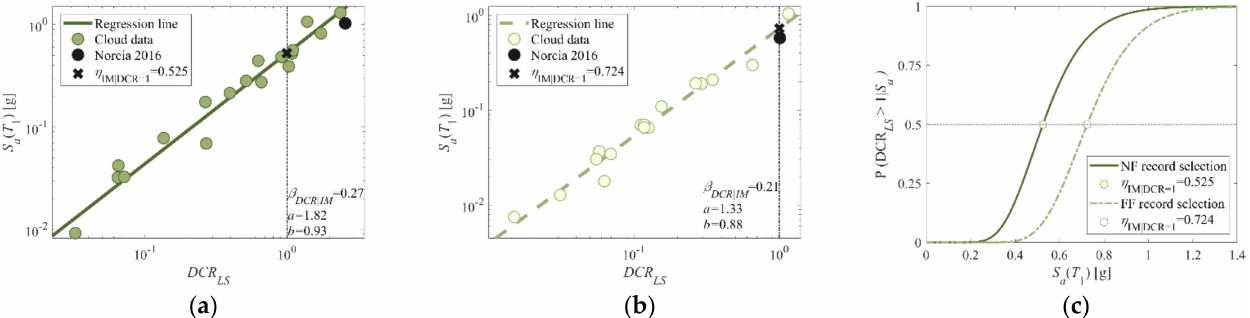
Figure 12. D-CA: ( a ) comparison among dynamic analysis cloud data regressions for near-fault record selection and ( b ) far-field record selection; ( c ) comparison between the two fragility curves